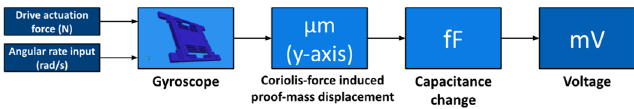
Figure 9. Linear vibratory MEMS gyroscope system-level model.